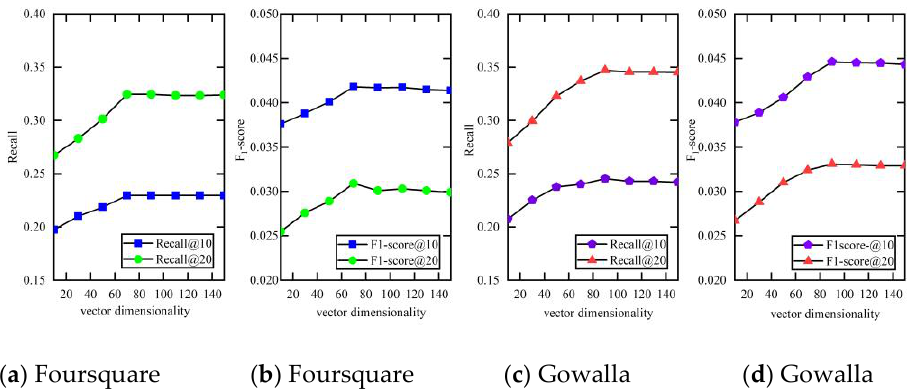
Figure 8. Effect of the number of dimensions in ATST-GRU. Figure 8. E ff ect of the number of dimensions in ATST-GRU.